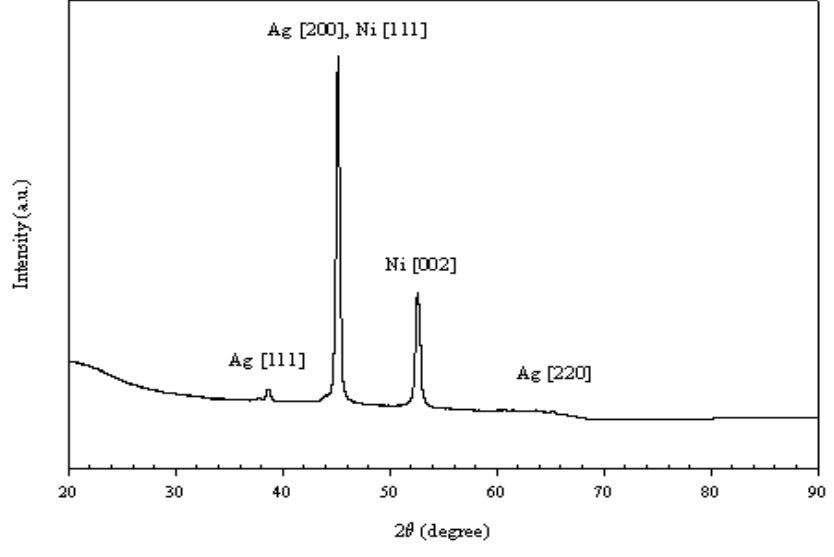
Figure 11. WAXD di ff raction pattern for Ag-coated Ni nanofibers. Figure 11. WAXD diffraction pattern for Ag-coated Ni nanofibers.